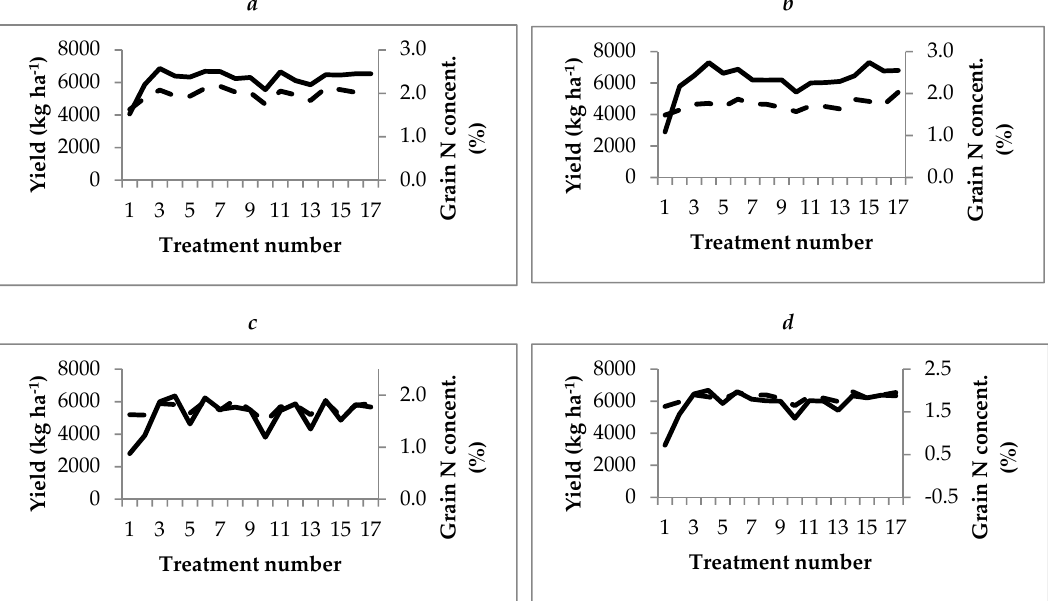
Figure 2. Relationship between wheat yields and grain nitrogen concentrations during the growing cycles of ( a ) 2010–2011, ( b ) 2011–2012, ( c ) 2011–2012, and ( d ) the average of the three cycles at the International Maize and Wheat Improvement Center (CIMMYT) experimental station, near Ciudad Obregon, Sonora in northwestern Mexico. The Solid lines represent yields and the dashed lines represent grain N concentration.